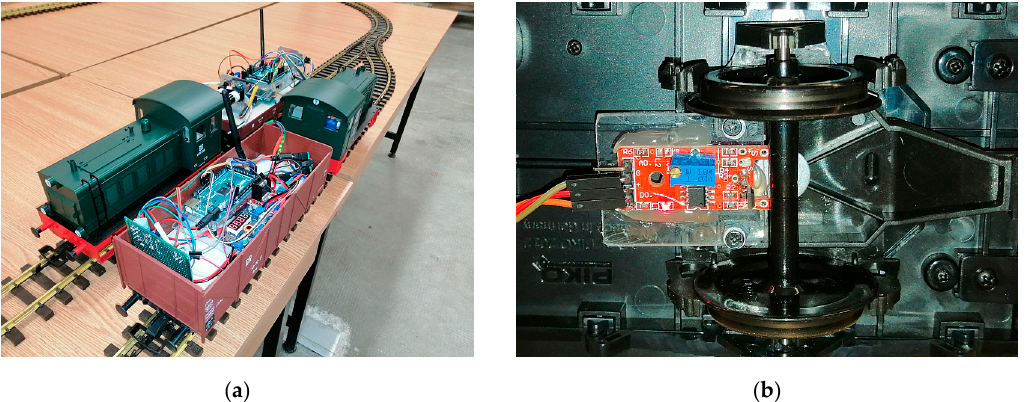
Figure 10. Experimental setup: ( a ) both mobile platforms—SLAVE#2 in the front and SLAVE#1 in the back; ( b ) speedometer with Hall sensor and magnet on the axle.